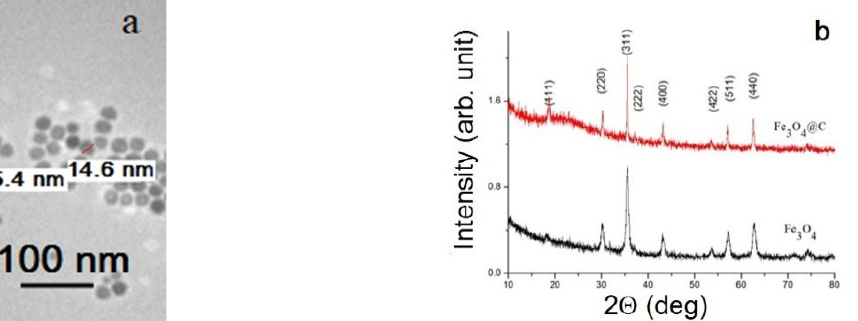
Figure 3. TEM image of the initial Fe 3 O 4 NPs ( a ) and XRD patterns for Fe 3 O 4 and Fe 3 O 4 @C NPs ( b ).